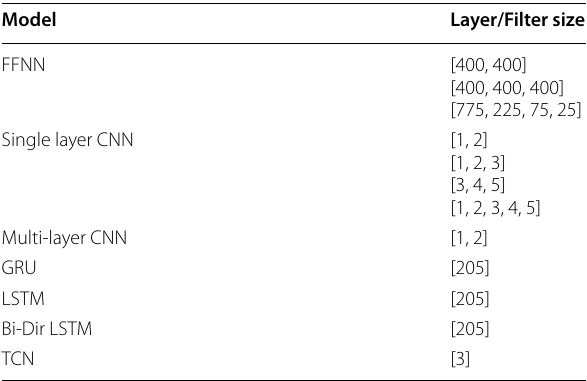
Table 3 Configuration setting for each architecture